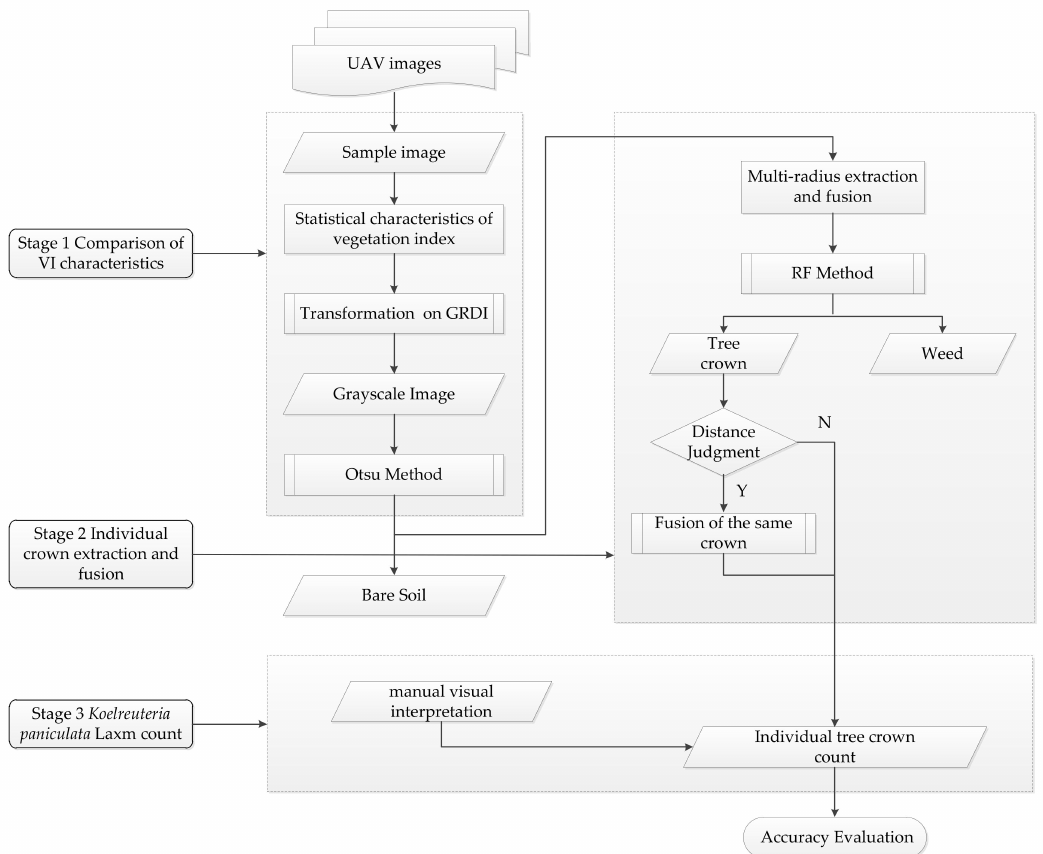
Figure 3. Flow chart of the proposed individual tree crown count